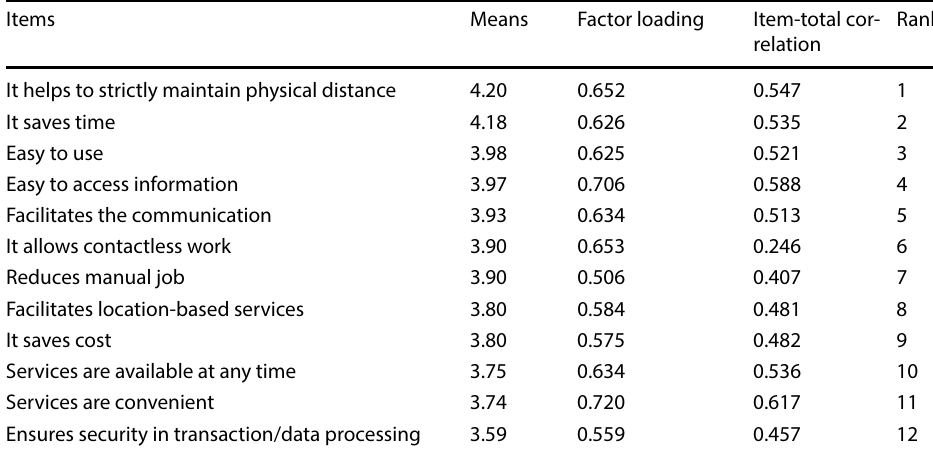
Table 3 Participants’ perceptions about the benefits experienced while using IoT